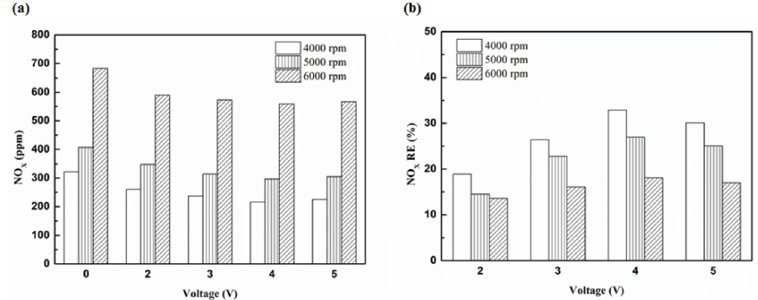
Figure 30. The NO x ( a ) emission values and ( b ) RE using platinum and in the rear of the exhaust pipe.